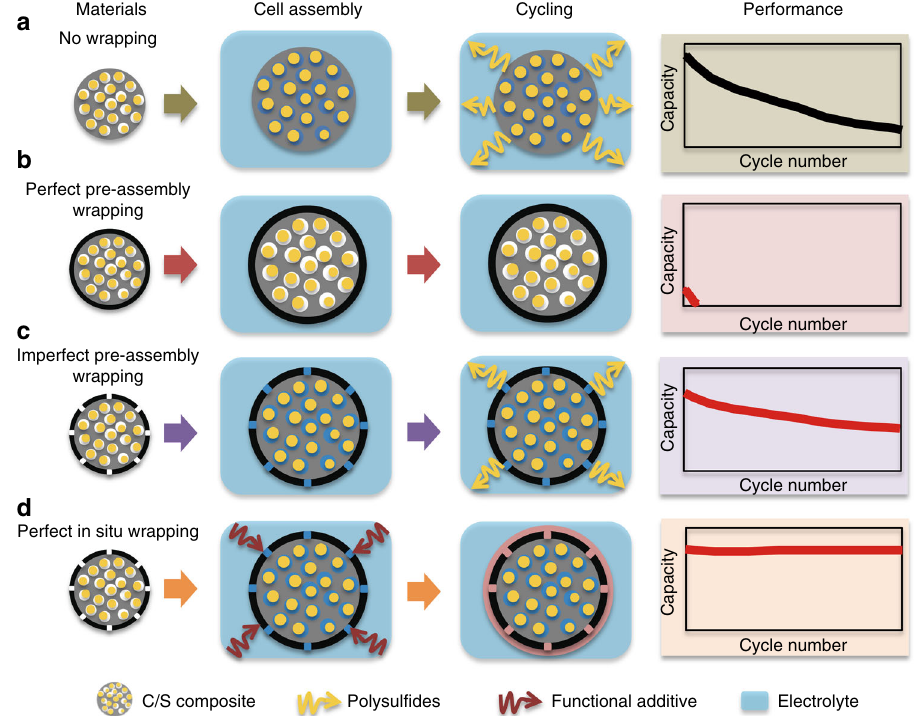
Fig. 1 Schematic illustration of the unique in situ wrapping strategy for lithium – sulfur cathode structures. a The no wrapping case, which exhibits severe capacity decay during cycling. b Perfect wrapping of the C/S materials prior to battery assembly, which exhibits poor overall performance due to the lack of electrolyte in the active material. c Imperfect wrapping of the cathode material prior to battery assembly, which exhibits improved cycle stability compared with the no wrapping case. d Perfect post-assembly in situ wrapping of the cathode material, which exhibits ideal cycle stability using a blocking polysul fi de shuttle while allowing for electrolyte in fi ltration in the active